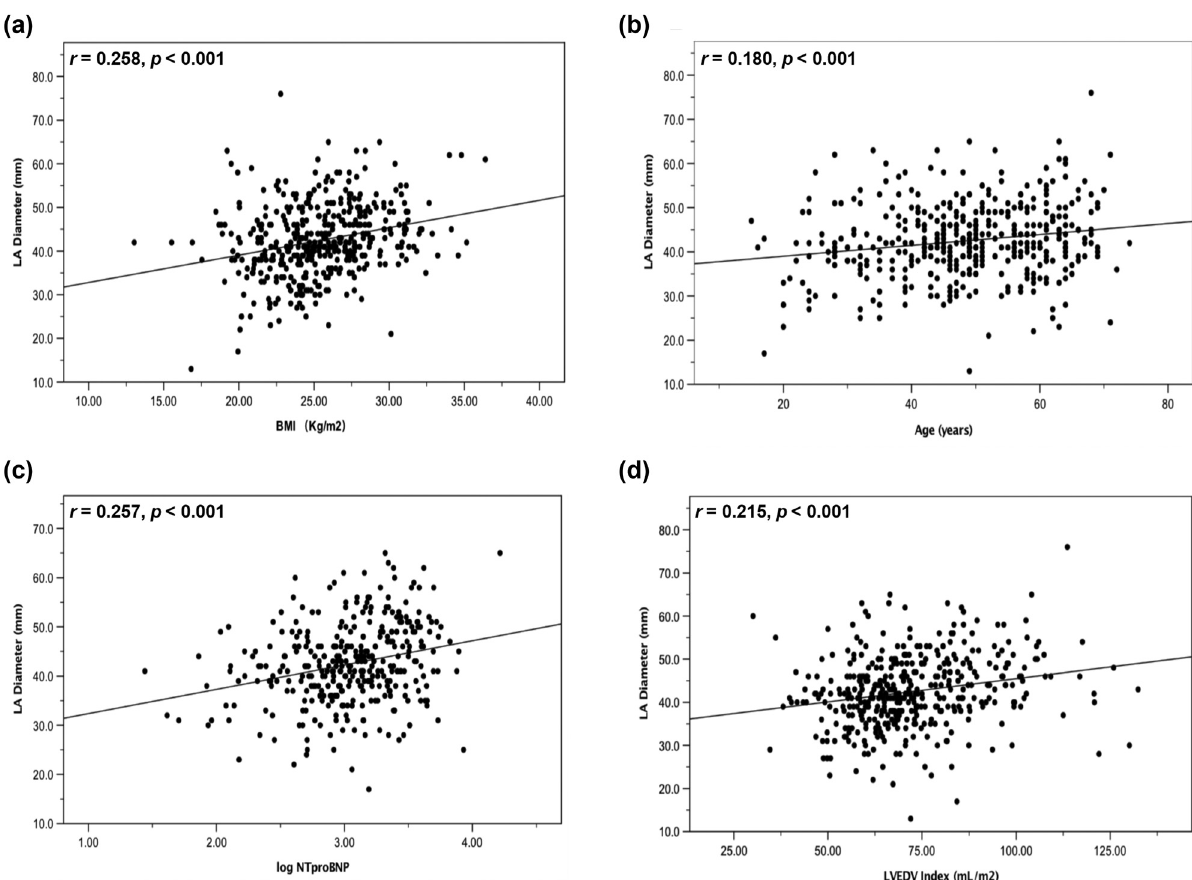
Figure 3: Scatter plots demonstrating the correlations between LAD and BMI ( a ) , age ( b ) , log NT - proBNP ( c ) , and LVEDVI ( d ) . LAD, left atrial